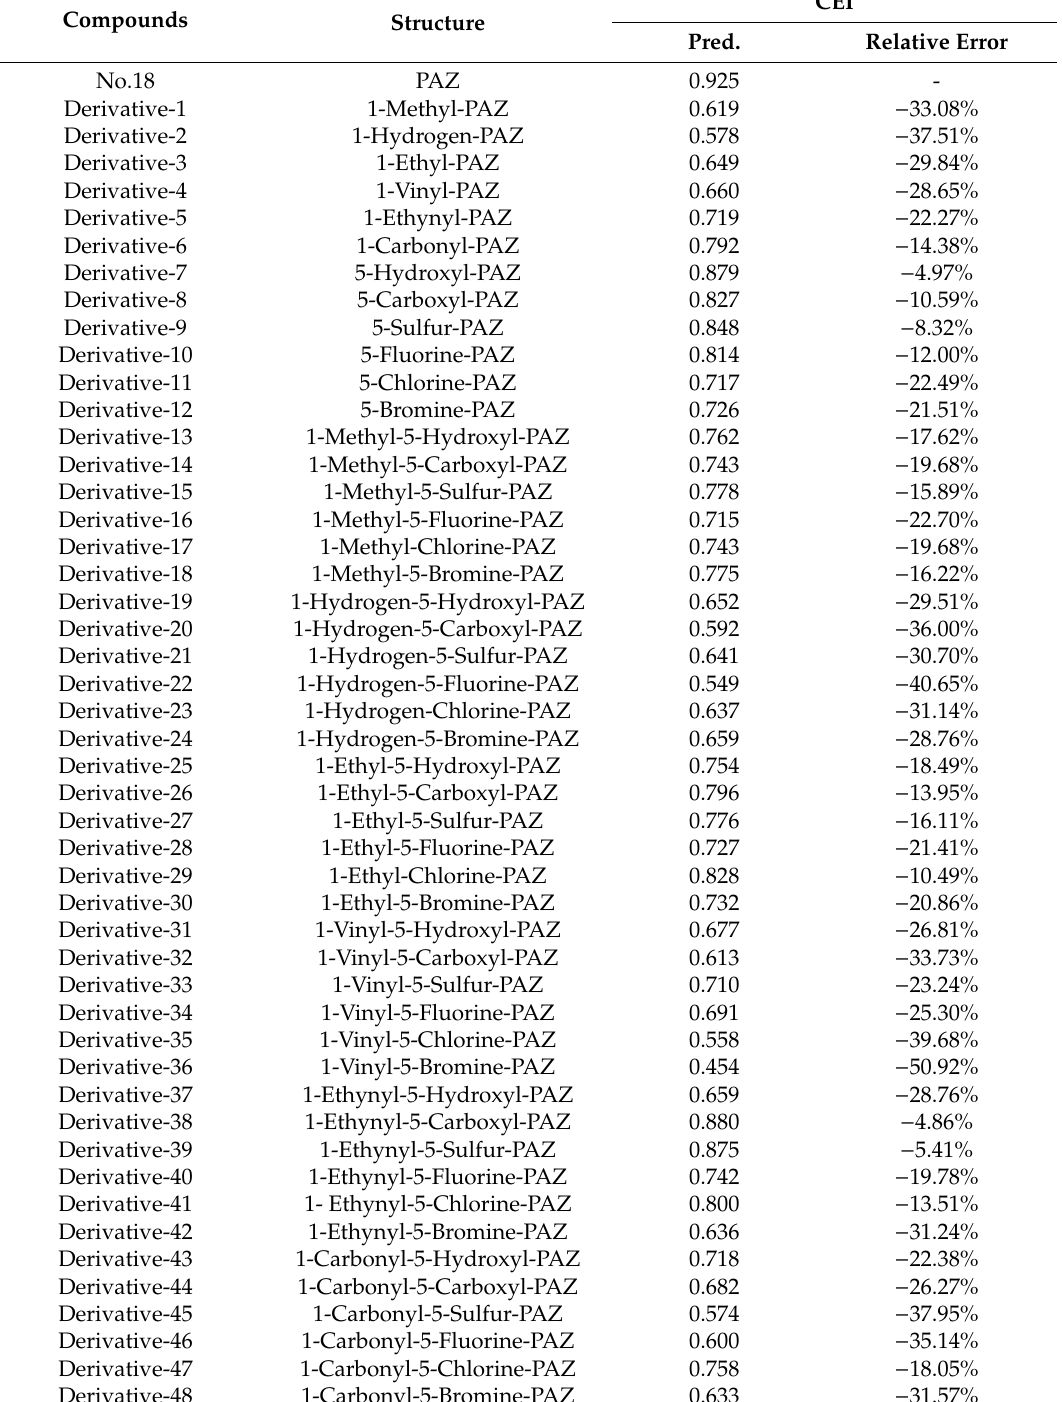
Table 4. Prediction of CEI index of derivatives based on CoMFA